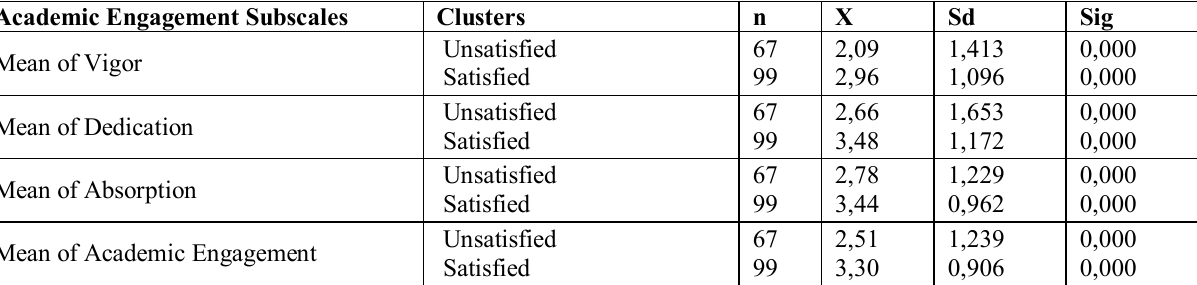
Table 5. T Test Statistics & Means of the